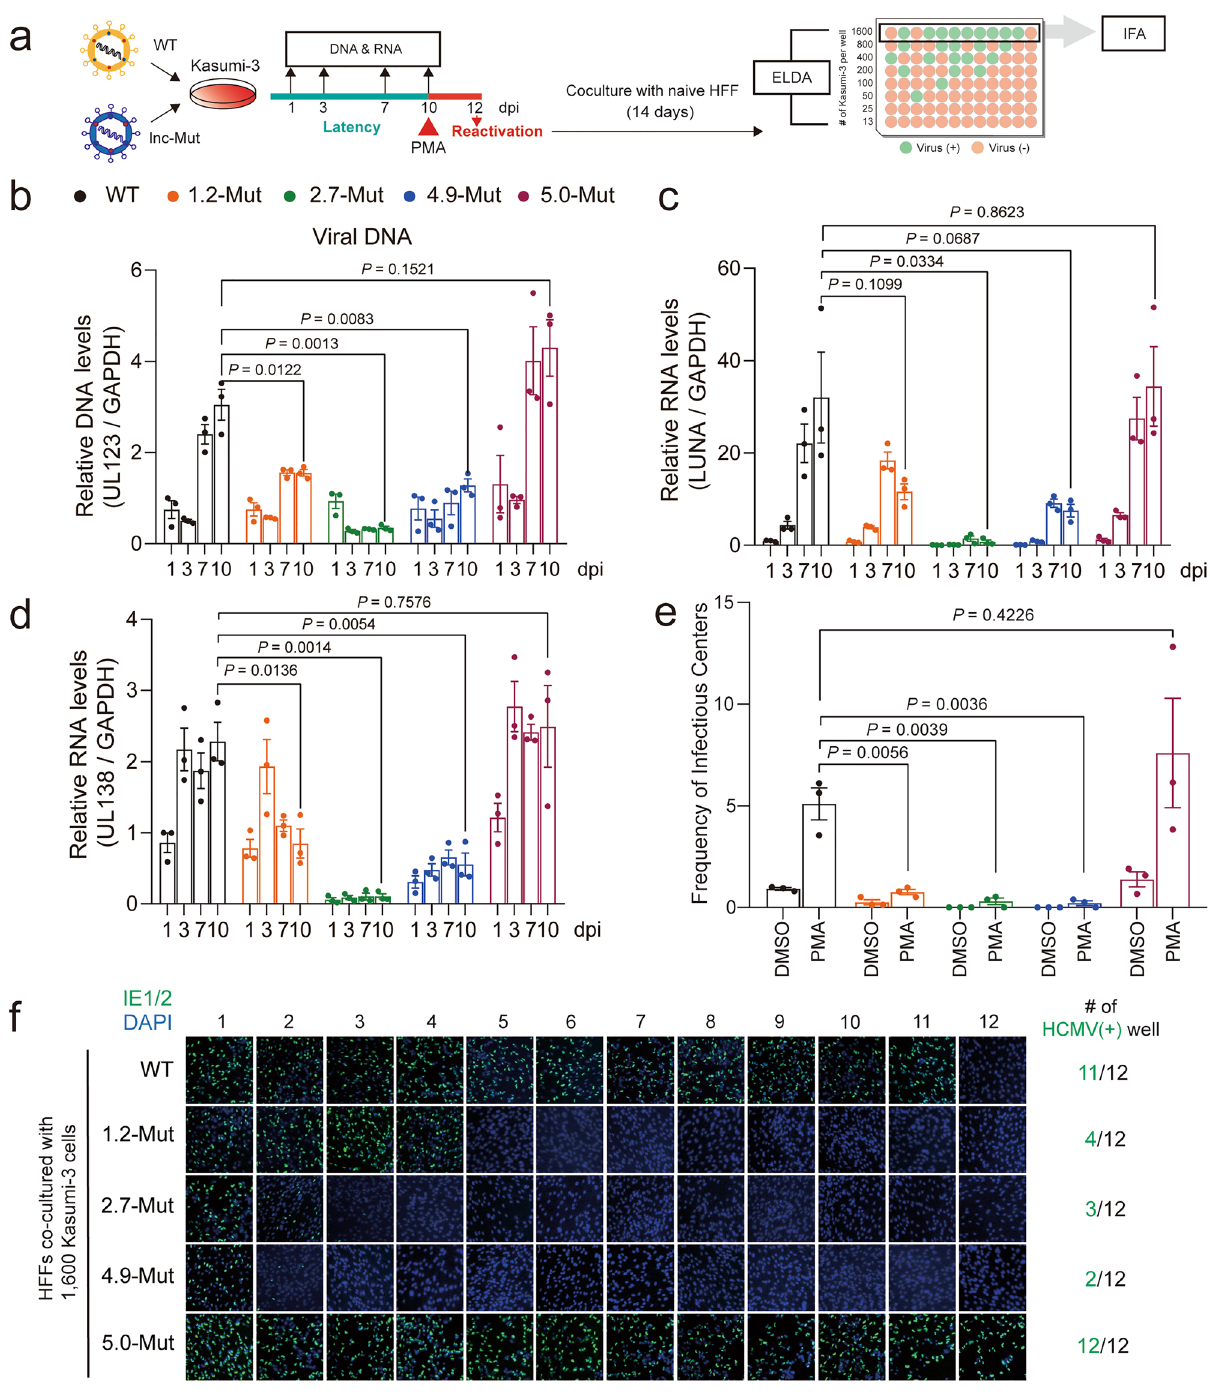
Figure 3. HCMV lncRNAs other than RNA5.0 are necessary for latent reservoir maintenance and efficient reactivation in Kasumi-3 cells. ( a ) Schematic representation of latency and reactivation analysis in Kasumi-3 cells using WT and lncRNA-Mut viruses. ( b ) The levels of viral DNA at the indicated time points were measured by qPCR of the UL123 region, and normalized against GAPDH. ( c , d ) The RNA levels of LUNA ( c ), and UL138 ( d ) at the indicated time points were quantified using qRT-PCR. ( e ) WT or lncRNA-Mut HCMV-infected Kasumi-3 cells were treated with DMSO or 20 nM PMA and co-cultured with naïve HFF cells. Frequency of infectious centers was calculated using ELDA. ( f ) Representative images of HFF cells co-cultured with 1600 PMA-treated Kasumi-3 cells for 14 days. Each image is obtained from each well of HFFs. IE1/2-positive images are presented on the left. Merged images are shown for IE1/2 (green), and DAPI (blue) staining. ( b – e ) Data represent mean ± SEM. All experiments were performed independently (n = 3), and the statistical significance was calculated by two-tailed unpaired t